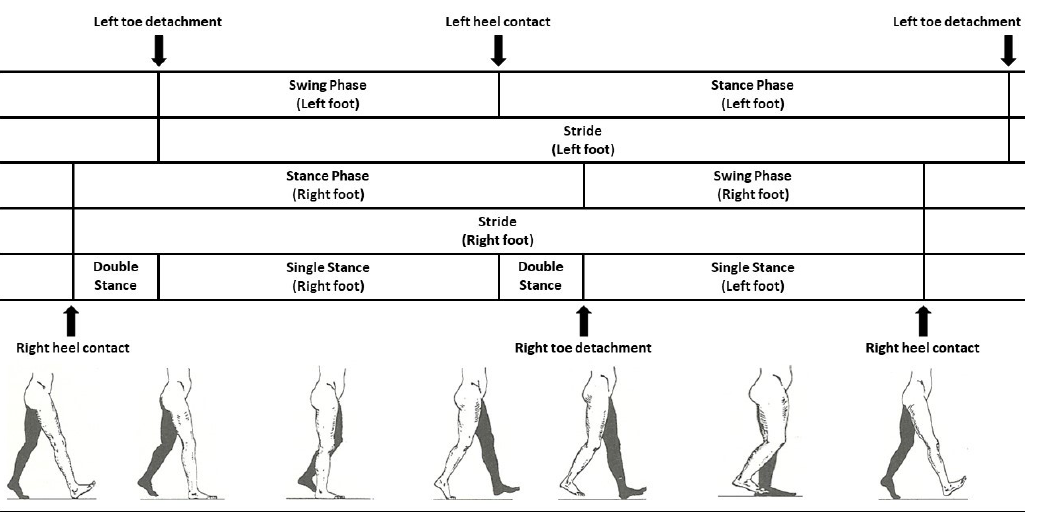
Figure 1. Gait-phase representation; swing, stance and double stance phases for both feet